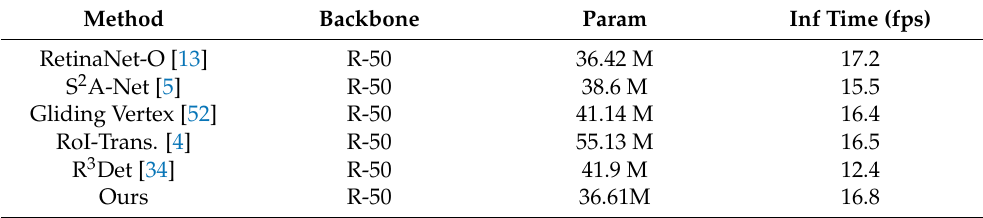
Table 5. Model size and efficiency. For a fair comparison, all the models utilized ResNet-50 as the backbone with a single NVIDIA RTX 2080S GPU.